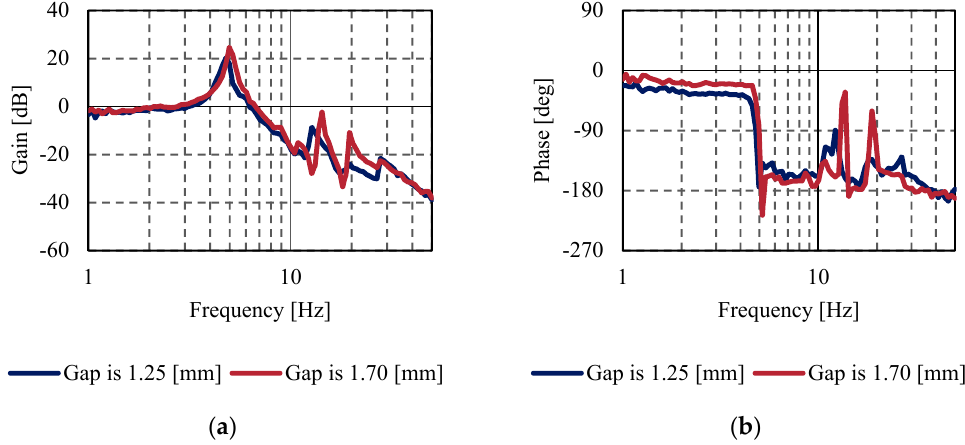
Figure 16. The frequency responses of the suspension to disturbance to the floator when the gap x is 1.25 mm and 1.70 mm: ( a ) gain diagram; ( b ) phase diagram.